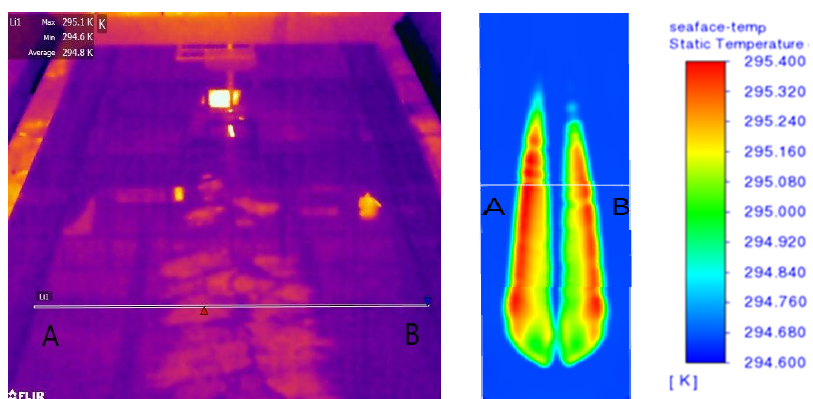
Figure 9. Comparison of water surface temperature field.